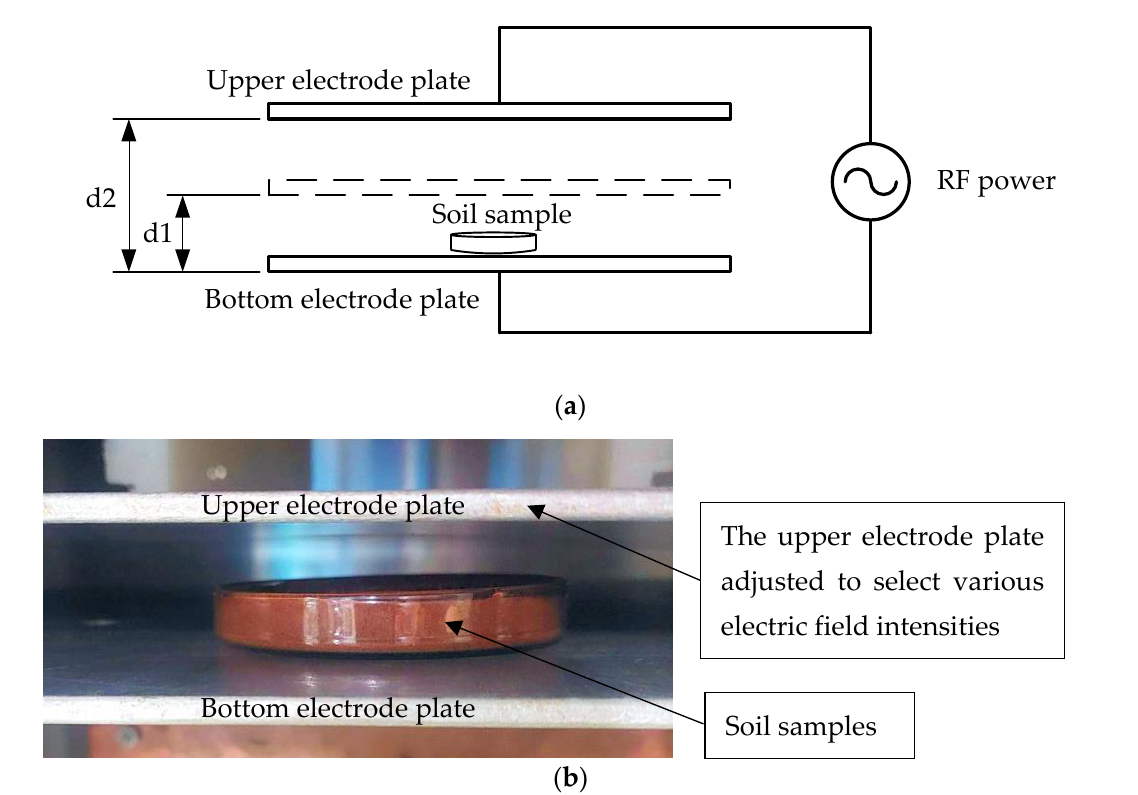
Figure 2. Schematic diagram of RF heating system: ( a ) Soil samples used for radio frequency heating system. ( b ) Radio frequency heating system.